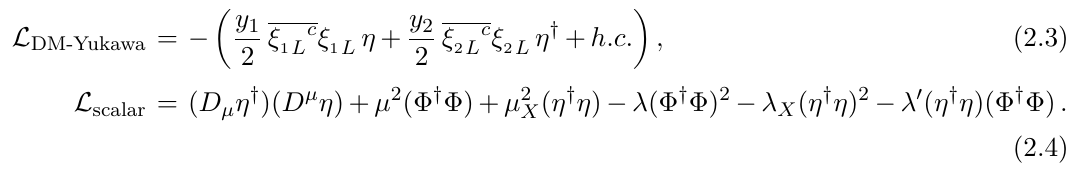
. ⊗ SU(2) ⊗ U(1) ⊗ U(1) c L Y X